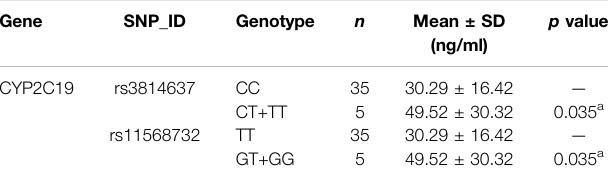
TABLE 3 | Correlation between different genotypes and anlotinib plasma peak concentration.